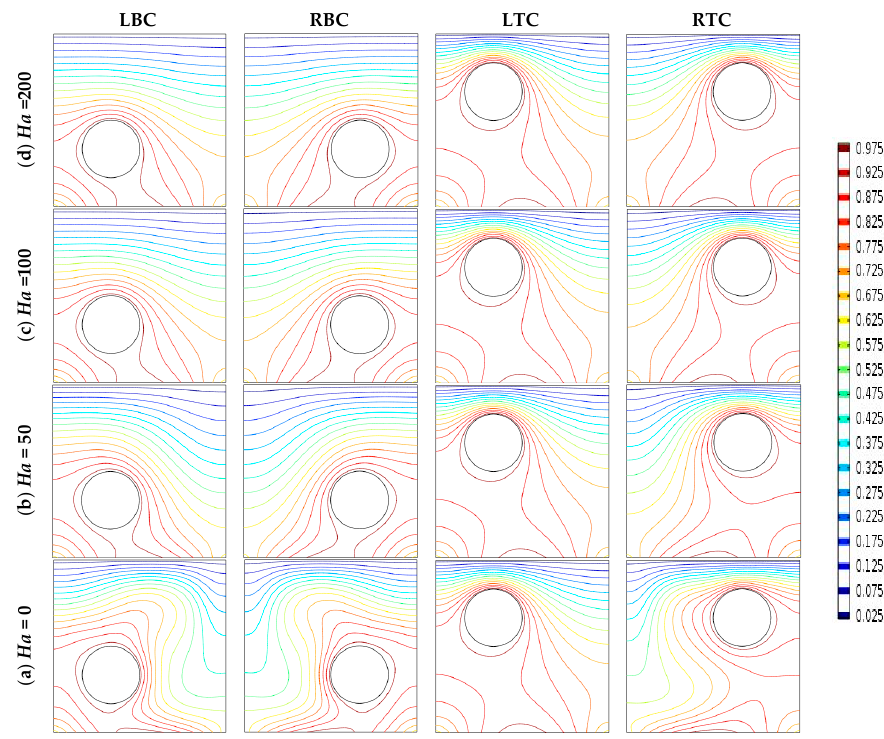
Figure 8. Isotherms for different orientations of heated cylinders for Ha = 0–200, Ra = 10 5 and Pr = 0.71 .